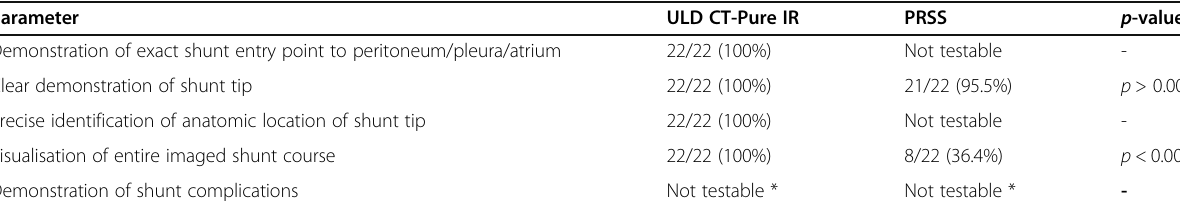
Table 3 Clinical parameters of the studied subjects